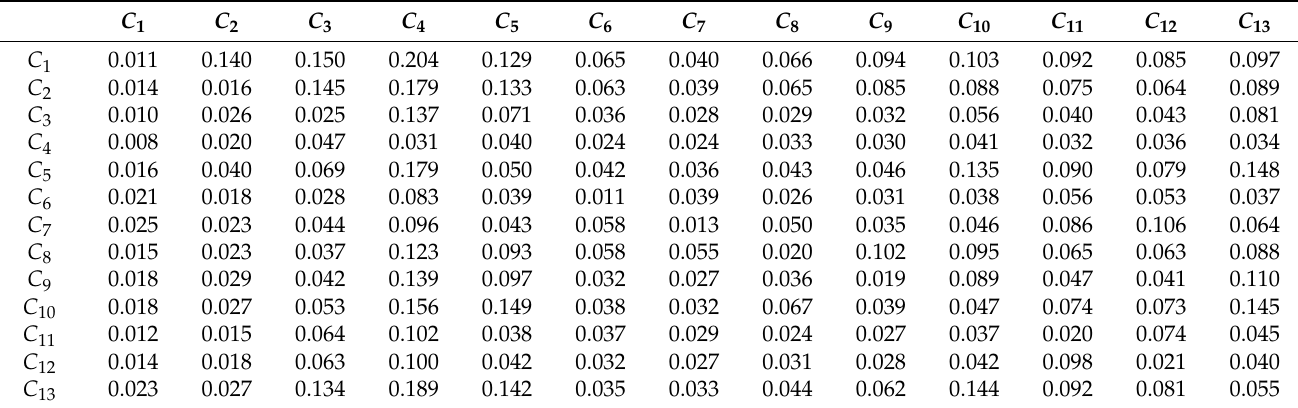
Table 4. Total influence matrix T .